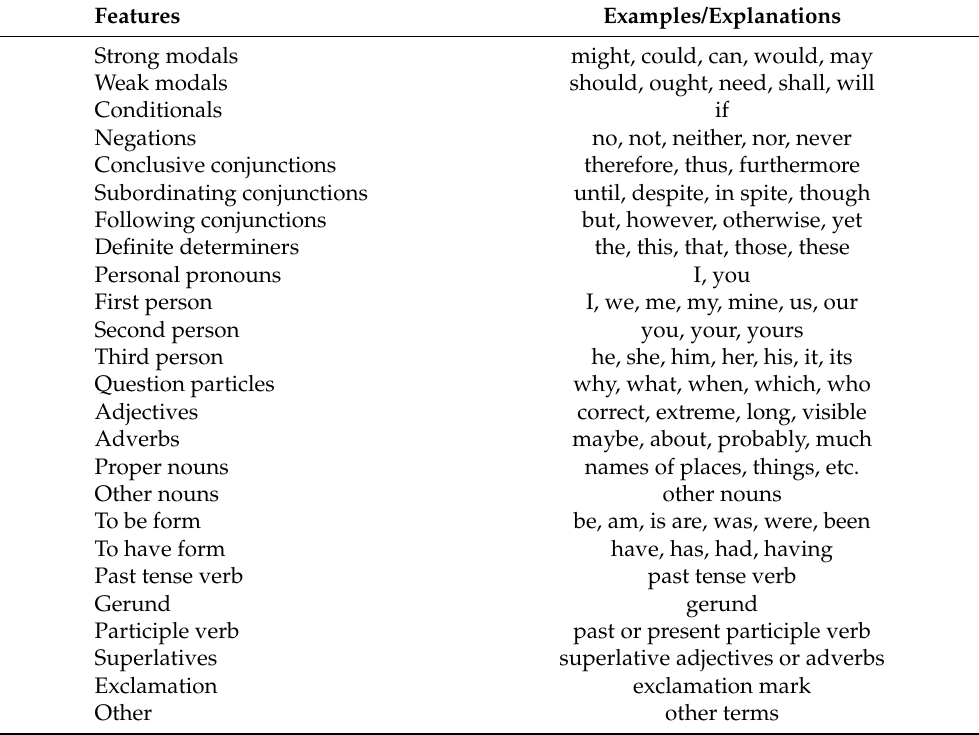
Table 3. List of the linguistic-stylistic features